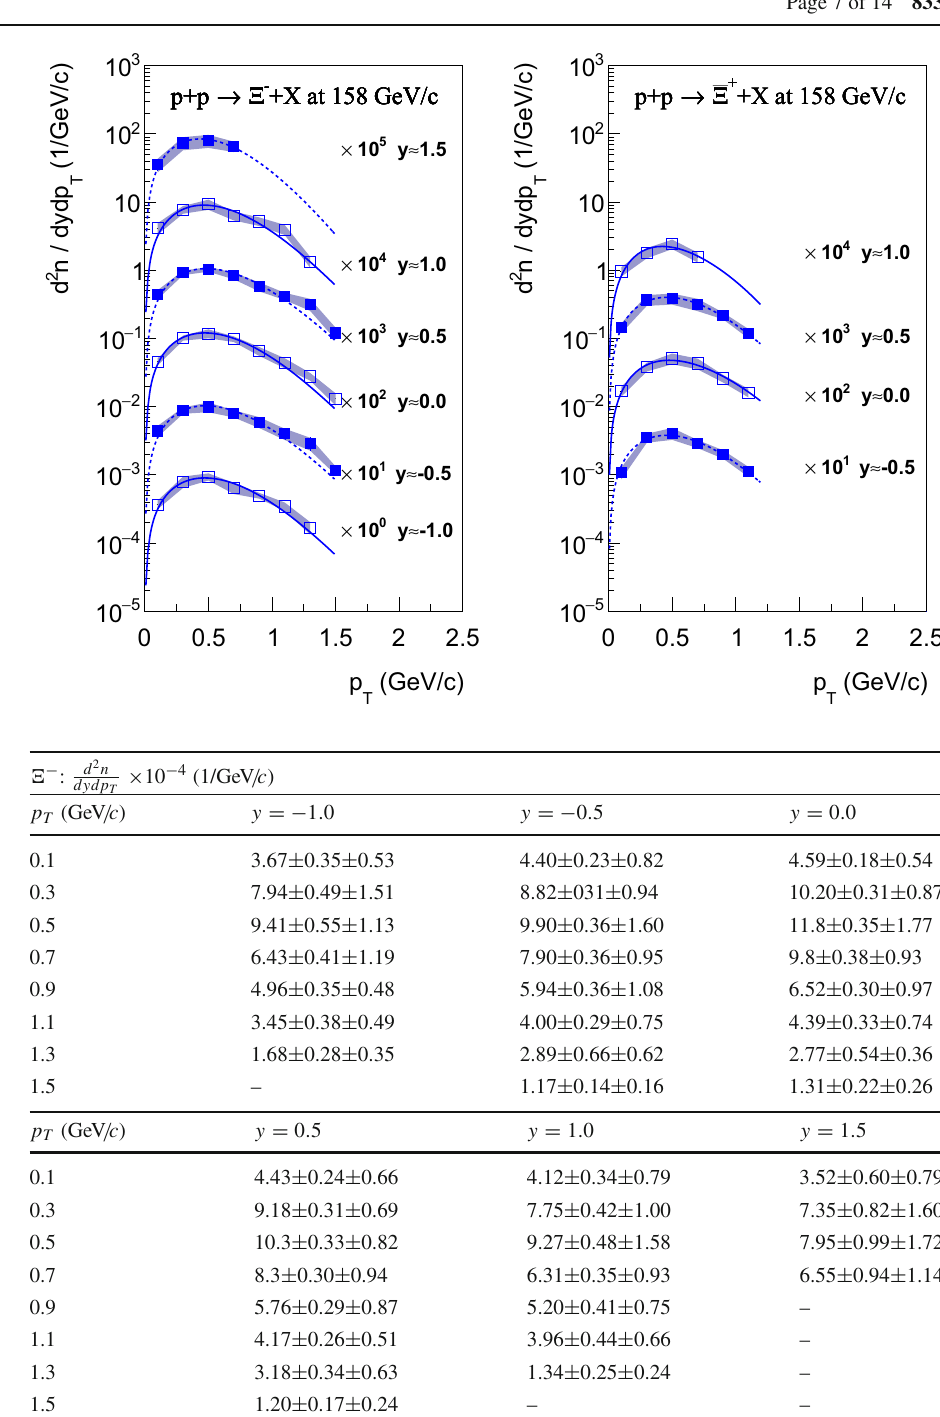
Table 2 Numerical values of double-differential spectra of (cid:2) − produced in inelastic p+p interactions at 158 GeV / c beam momentum. Rapidity and transverse momentum values correspond to the middle of the presented bin. First value is the particle multiplicity, second represents the statistical uncertainty and third one corresponds to the estimated systematic